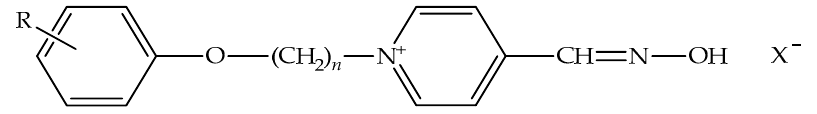
Figure 16. Representation of the general chemical formula for the oxime molecules investigated.